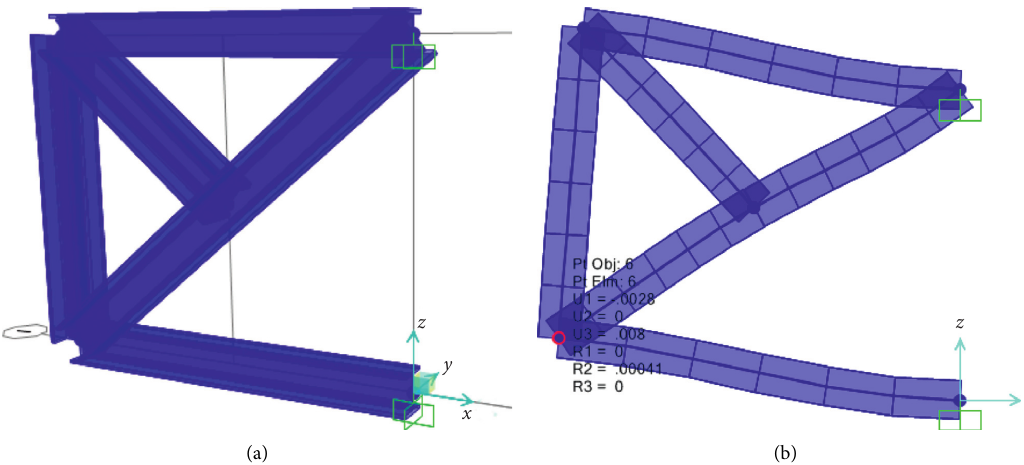
Figure 6: The outrigger FEM model: (a) before deformation; (b) after deformation.